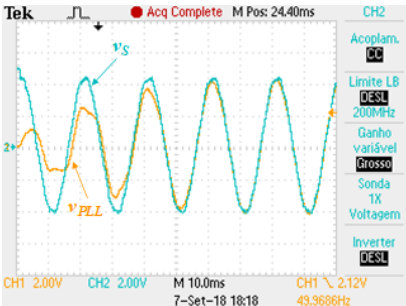
Figure 11. Experimental results of the proposed SAPF with reduced dc-link: Synchronism of the EPLL, v PLL , with the power grid voltage, v S .